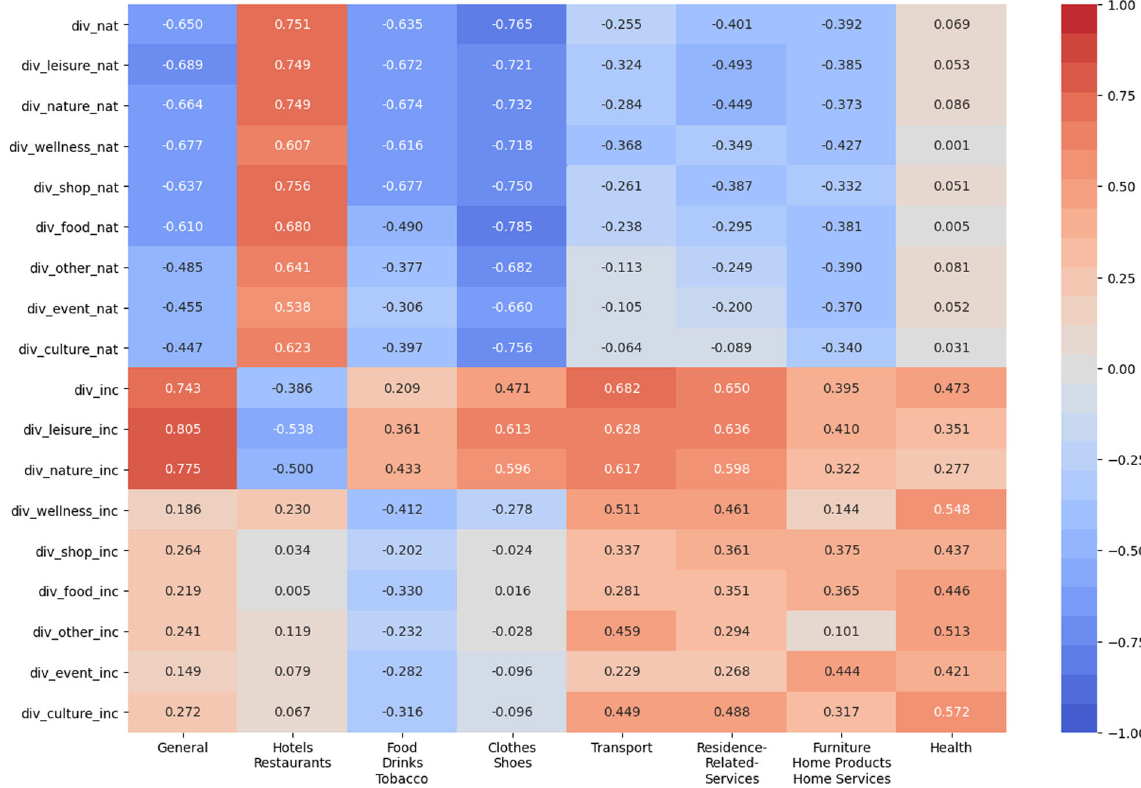
Fig. 3 Correlation between diversity measures and CPI. Heatmap of Pearson correlation in diversity measure ( x -axis) and CPI ( y -axis). The top nine rows are nationality-related diversity measures. The bottom nine rows are income-related diversity measures. The value corresponds to Pearson correlation with the legend shown on the right. Blue to red corresponds to correlation coef fi cients ranging from − 1 to 1.